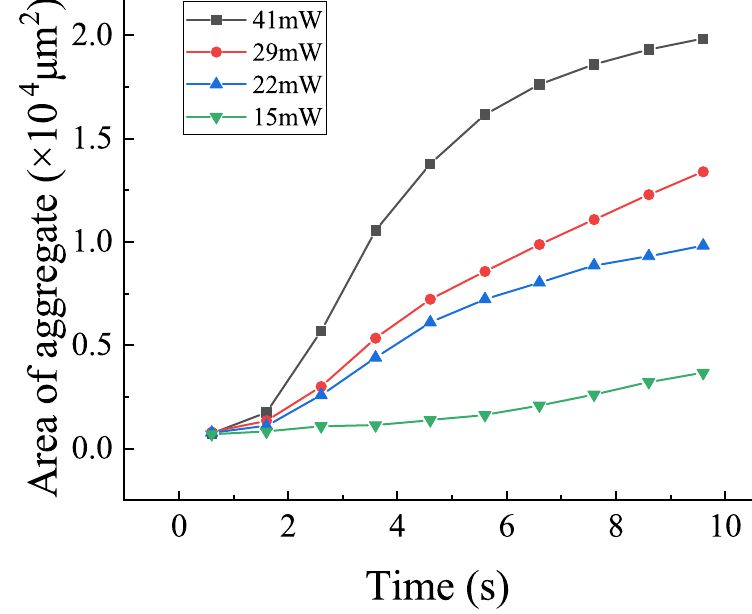
Figure 3. Areas of AP aggregates as a function of illumination time at different laser powers. The laser power was measured at the pupil of